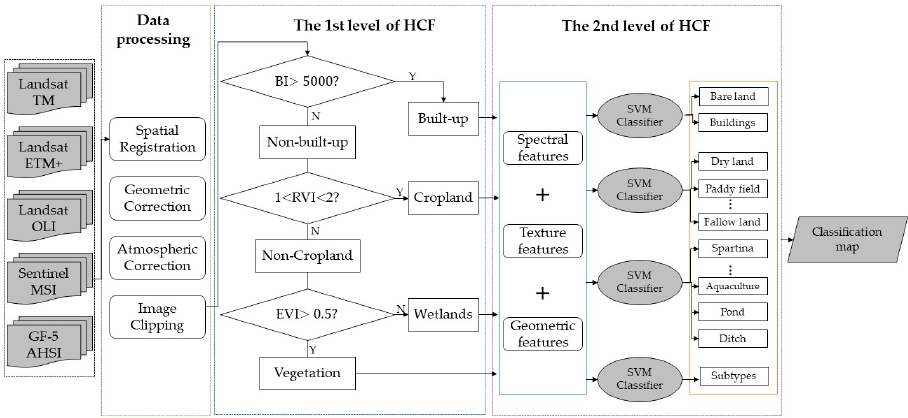
Figure 2. The flowchart of our hierarchical classification framework (HCF).